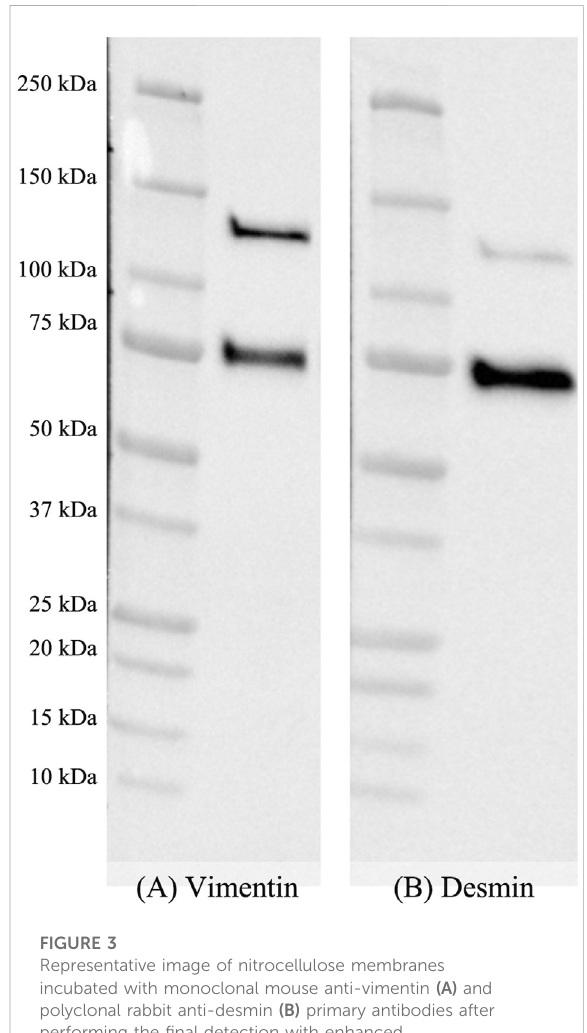
FIGURE 3 Representative image of nitrocellulose membranes incubated with monoclonal mouse anti-vimentin (A) and polyclonal rabbit anti-desmin (B) primary antibodies after performing the fi nal detection with enhanced